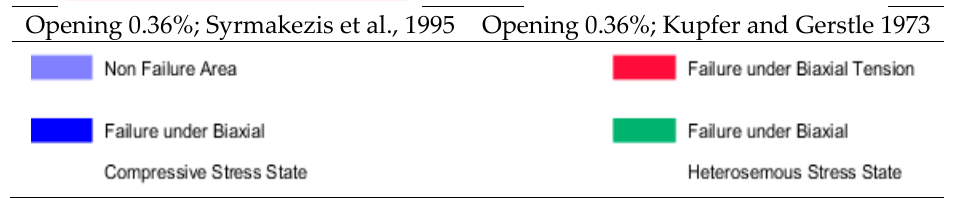
Figure 38. Failure of 2D masonry wall L100H100 (Figure 36b) for three different opening percentages, two different failure criteria and maximum ground acceleration value PGA = 0.32 g.